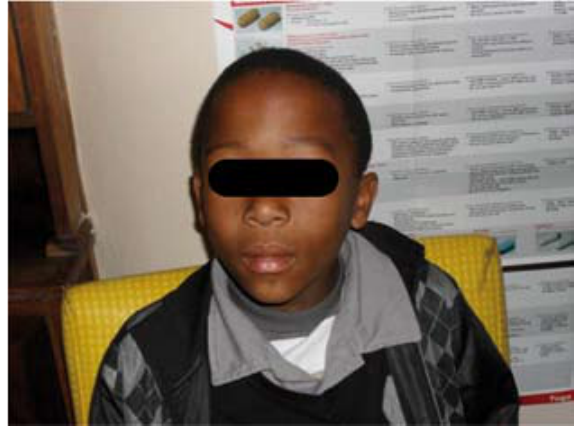
Fig. 3. The same child as in Fig. 1. Some recovery is seen 4 years after withdrawal of